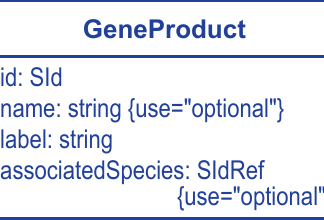
Table 1: Examples of chemical formulas written using the Hill System. As described in Section 3.4